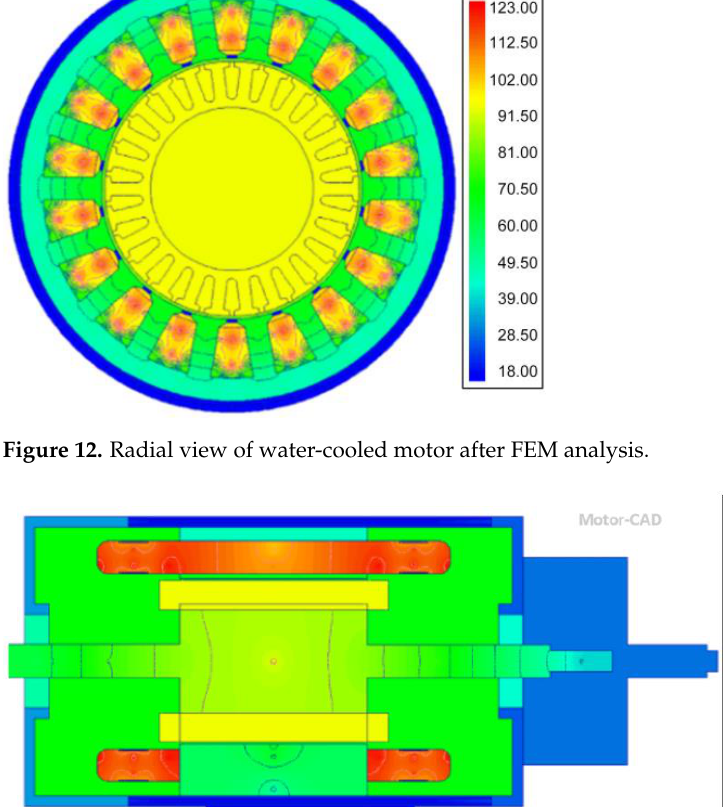
Figure 13. Axial view of water-cooled motor (aluminum casing) after the FEM analysis.